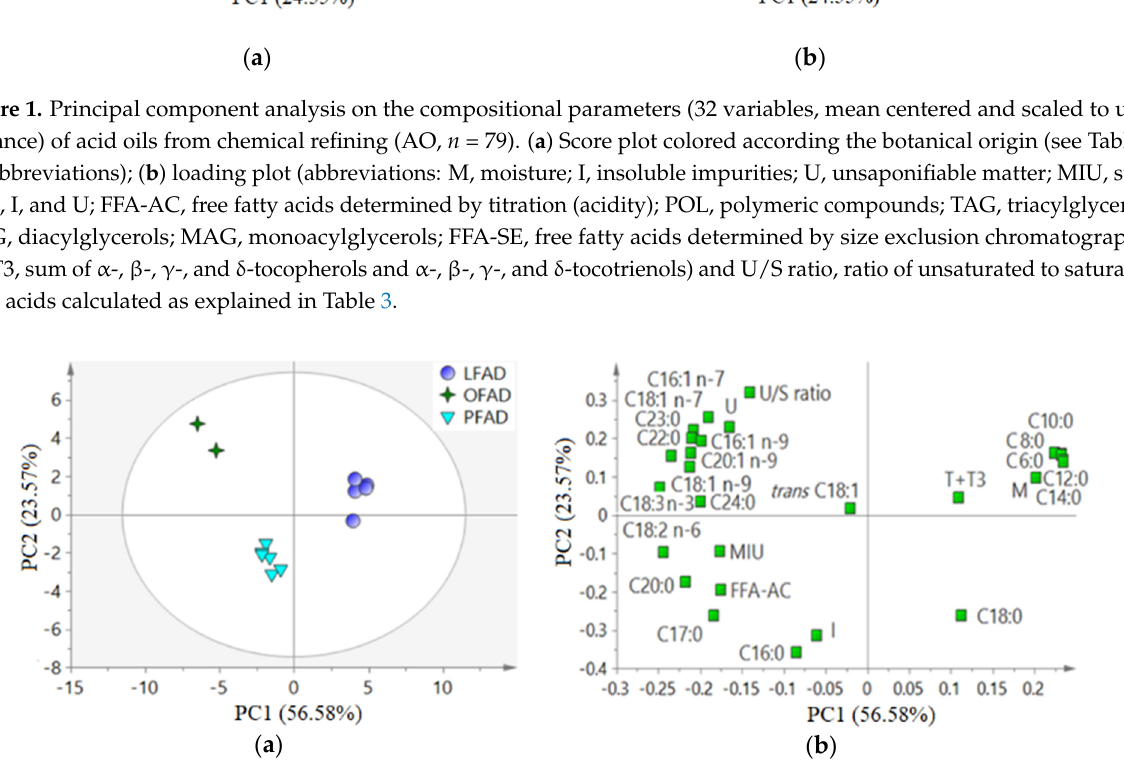
Figure 2. Principal component analysis on the compositional parameters (27 variables mean centered and scaled to unit variance, POL, TAG, DAG, MAG, and FFA-SE were excluded) of fatty acid distillates from physical refining (FAD, n = 13). ( a ) Score plot colored according the botanical origin (see Table 1 for abbreviations); ( b ) loading plot (see Figure 1 for abbreviations).